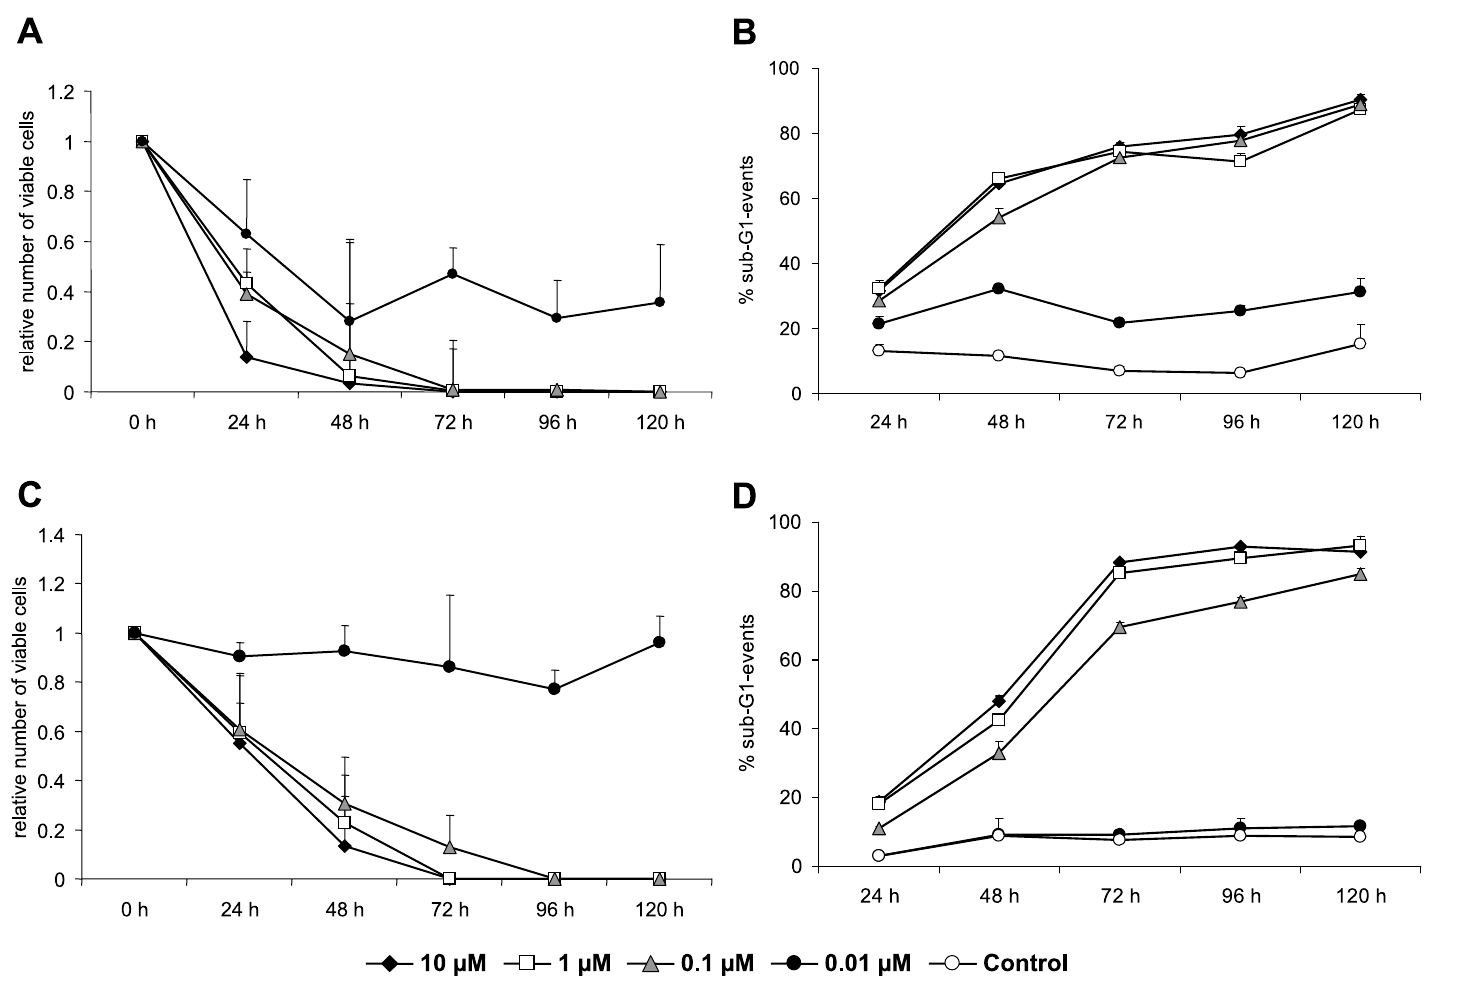
Fig. 1. Growth inhibition and induction of apoptosis in HCC cell lines by panobinostat. HepG2 (A, B) and Hep3B (C, D) were incubated with panobinostat as indicated. Proliferation (A, C) and apoptosis rate (B, D) were determined as described. Number of viable control cells was set at 1.0 in (A) and (C), other cell numbers are expressed relative to control. Shown are mean ± SEM of three independent